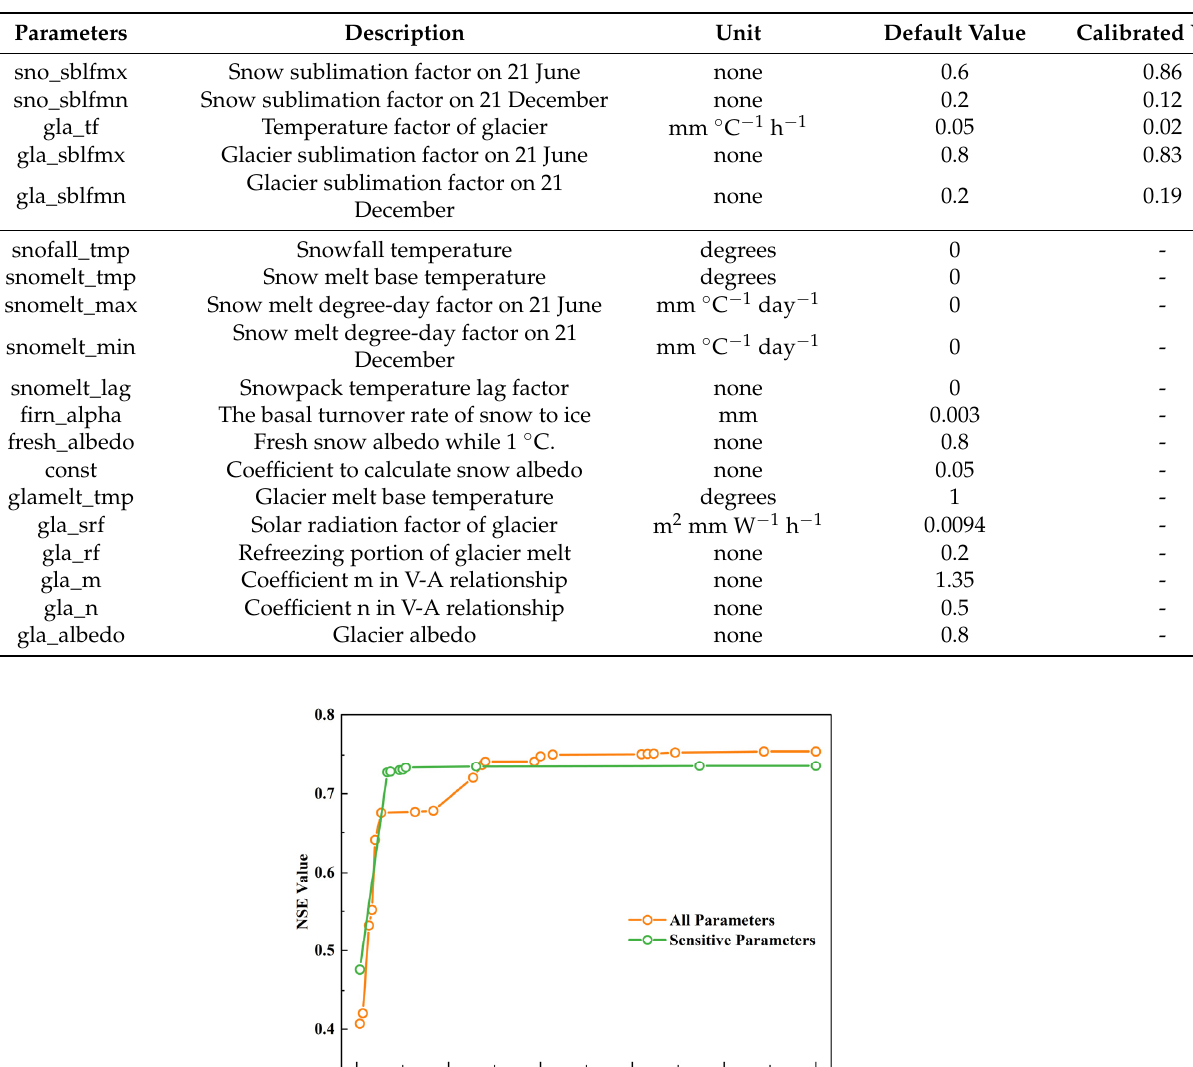
Table 2. Values of parameters related to glacier and snow processes.